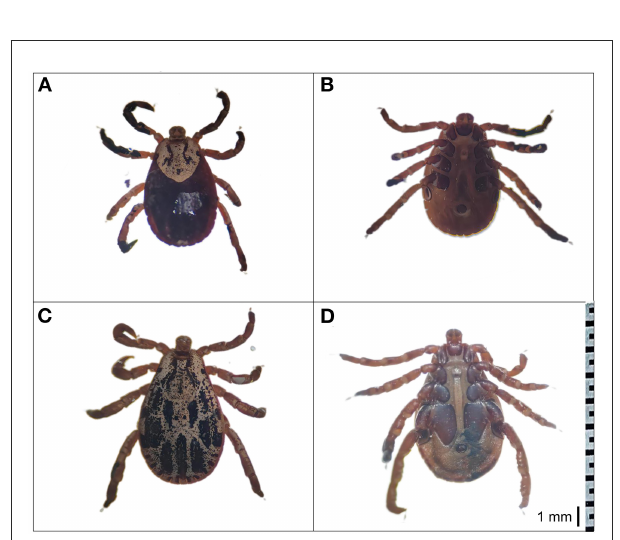
FIGURE2 Morphological characterization of D. nuttalli . The dorsal view and ventral view of D. nuttalli . All figures used the same ruler (1mm). (A) Dorsal view of female. (B) Ventral view of female. (C) Dorsal view of male. (D) Ventral view of